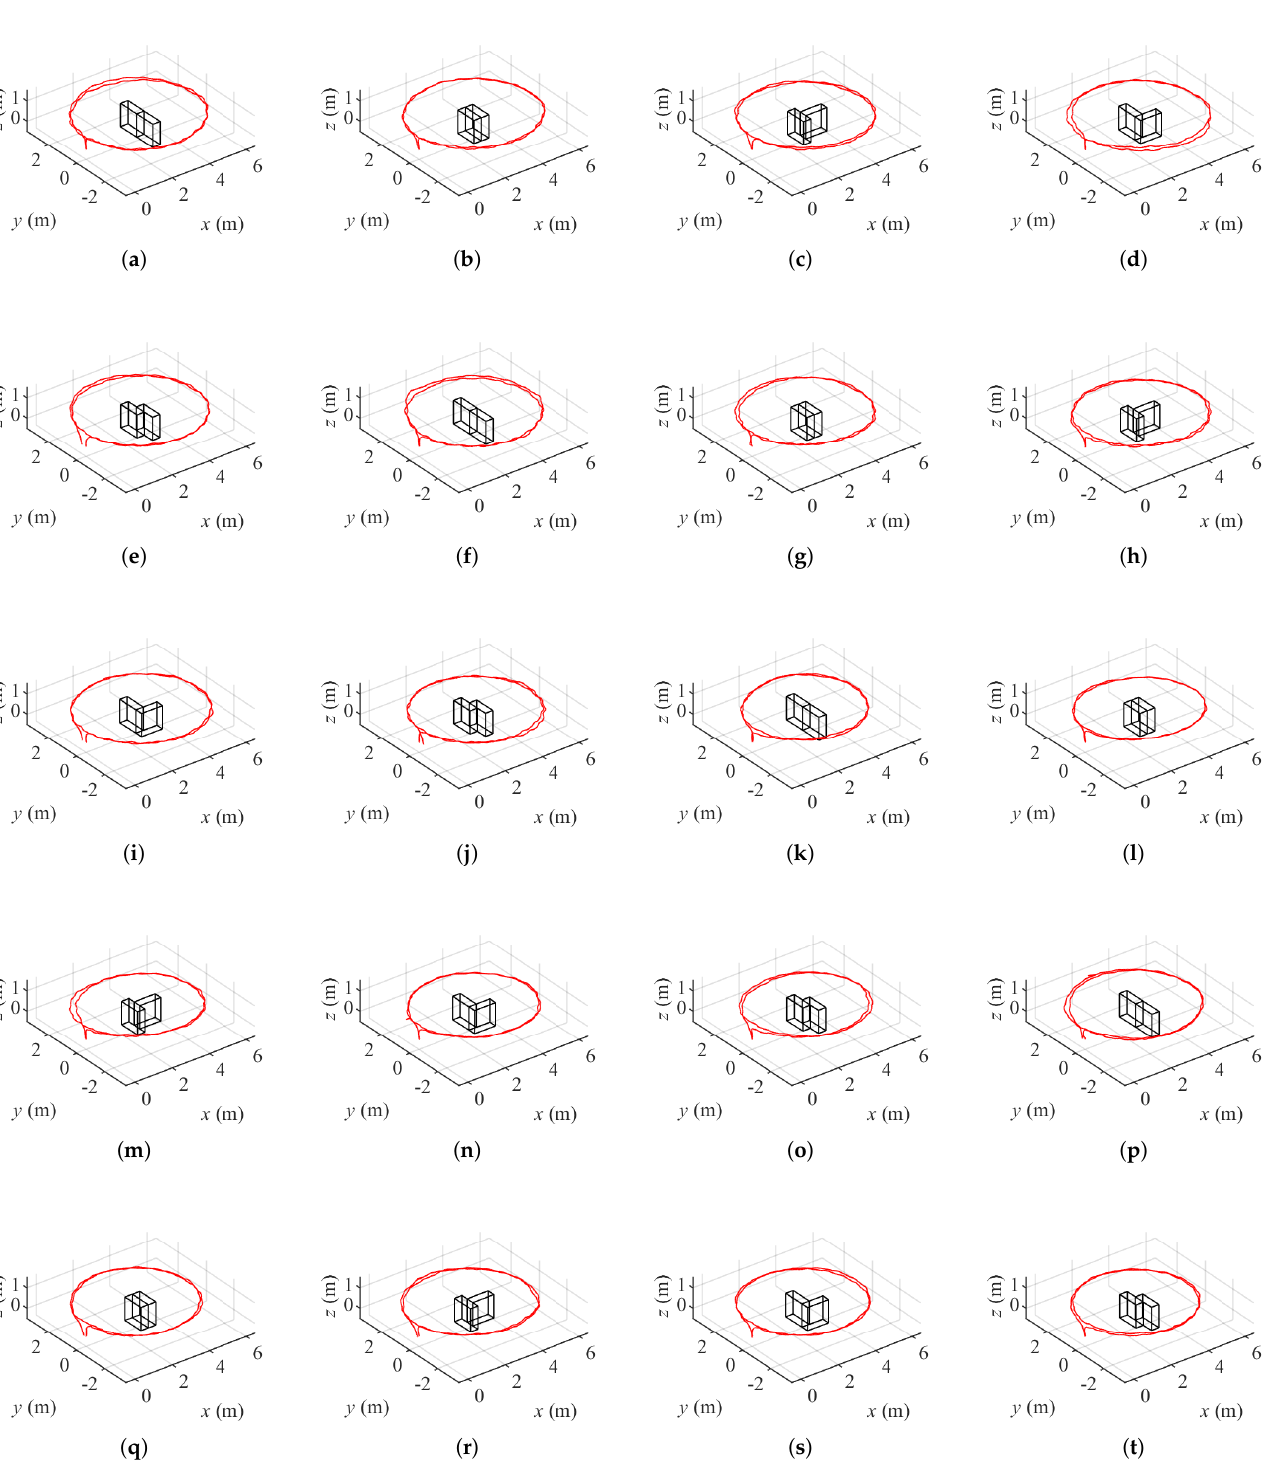
Figure 3. Camera trajectories of boxes of five layouts and two textures in two environments. ( a – e ) I, O, T, L and S layout boxes with Voronoi diagrams in front of buildings. ( f – j ) I, O, T, L and S layout plain boxes in front of buildings. ( k – o ) I, O, T, L and S layout boxes with Voronoi diagrams in the parking lot. ( p – t ) I, O, T, L and S layout plain boxes in the parking